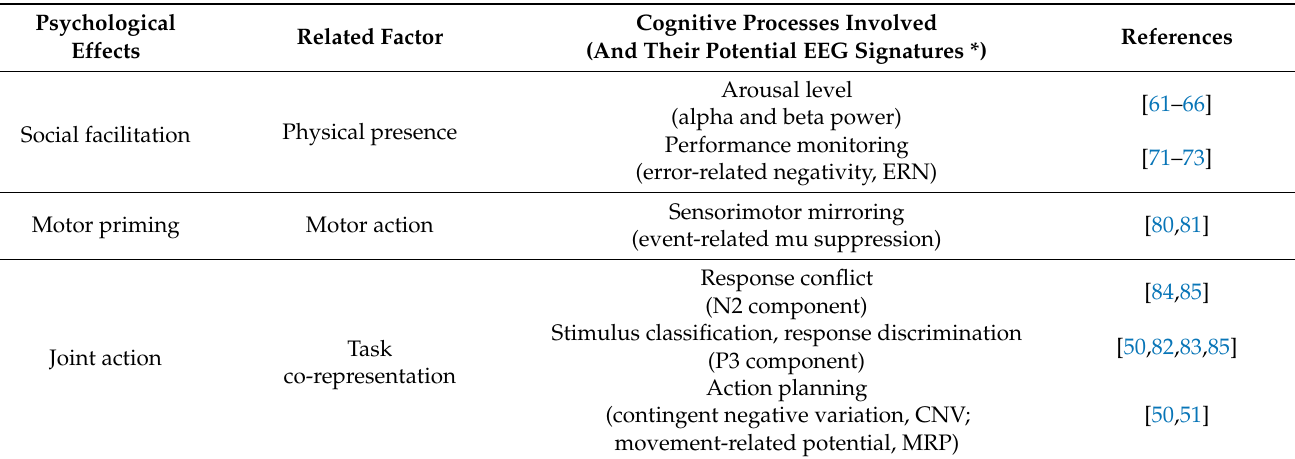
Table 1. Psychological effects in social interaction and their potential EEG